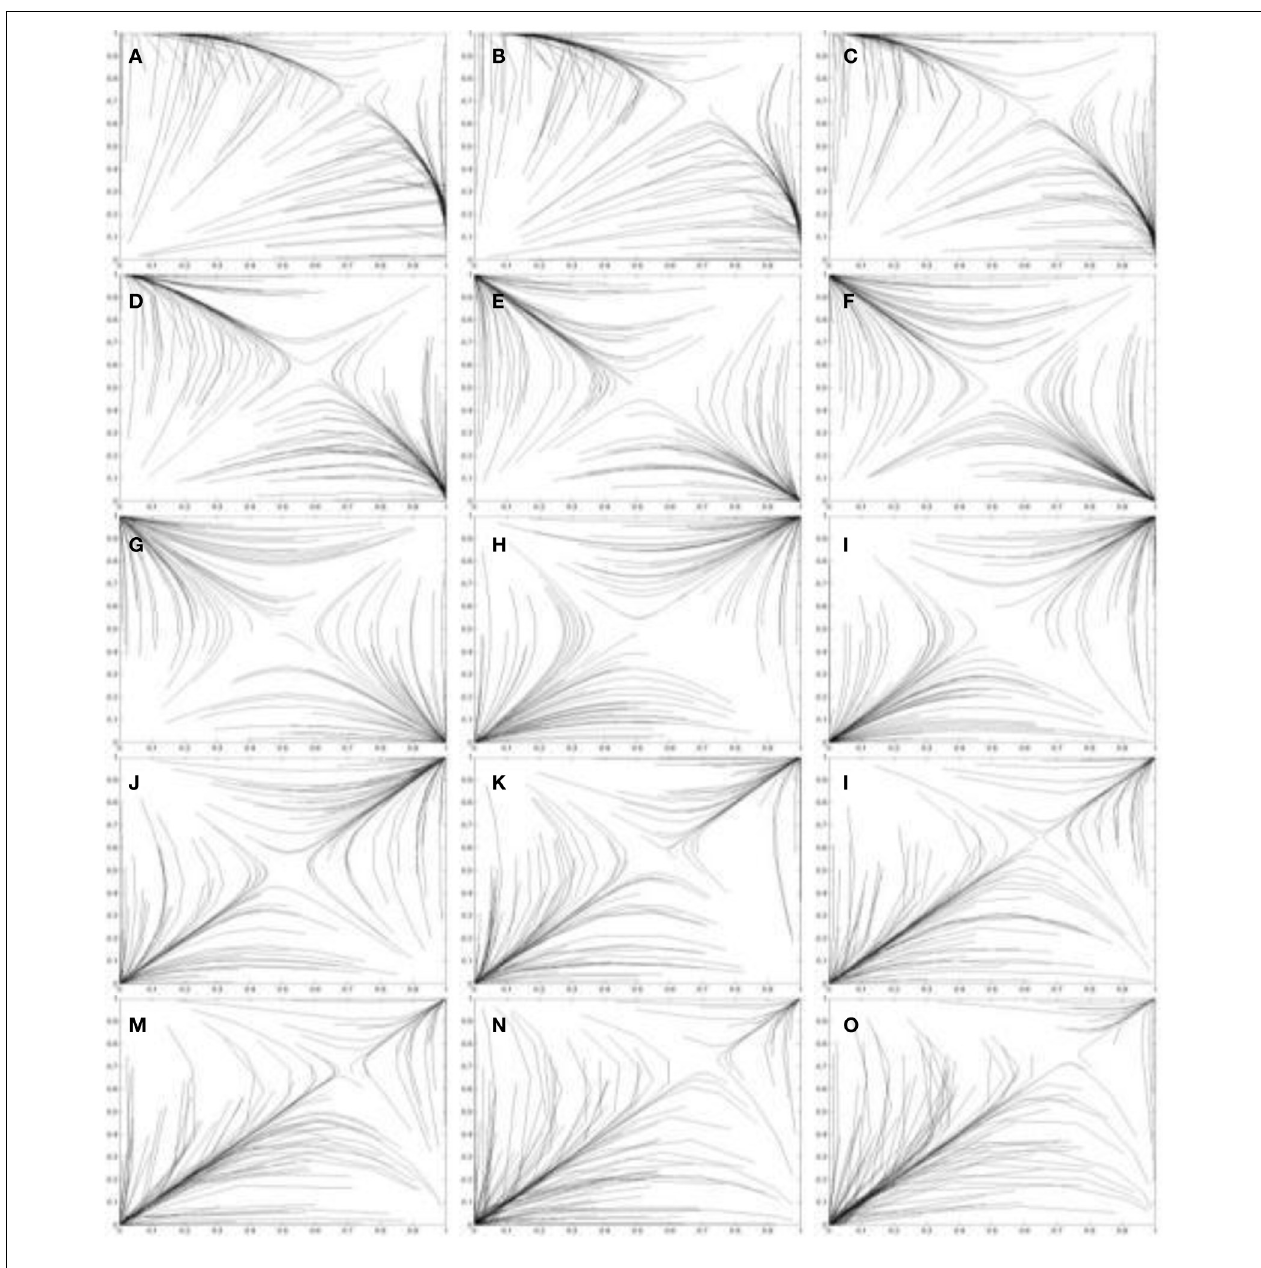
(E) I ∗ j = 3 . 0; (F) I ∗ j = 2 . 8; (G) I ∗ j = 2 . 6; (H) I ∗ j = 2 . 4; (I) I ∗ j = 2 . 2; (J) I ∗ j = 2 . 0; (K) I ∗ j = 1 . 8; (L) I ∗ j = 1 . 6; (M) I ∗ j = 1 . 4; (N) I ∗ j = 1 . 2; (O) I ∗ j = 1 . 0. Initial values of